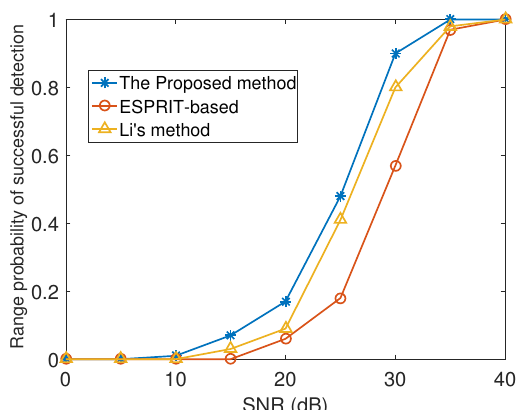
Figure 11. Probability of successful detection of range estimation versus SNR, L =